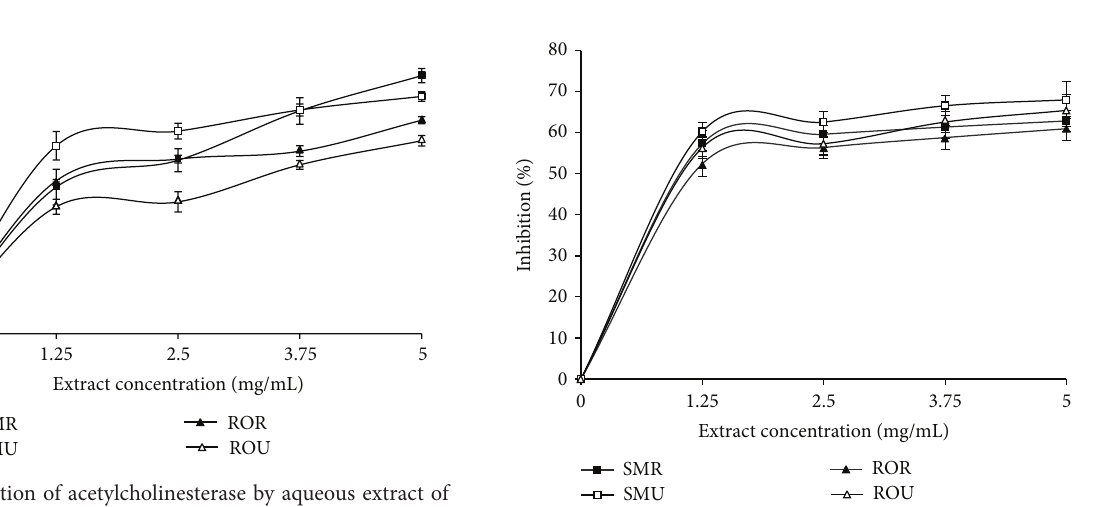
Figure 5: Butyrylcholinesterase inhibition by aqueous extract of Capsicum spp. SMU: Capsicum annuum var. accuminatum (unripe). SMR: Capsicum annuum var. accuminatum (ripe). ROU: Capsicum chinense (unripe). ROR: Capsicum chinense